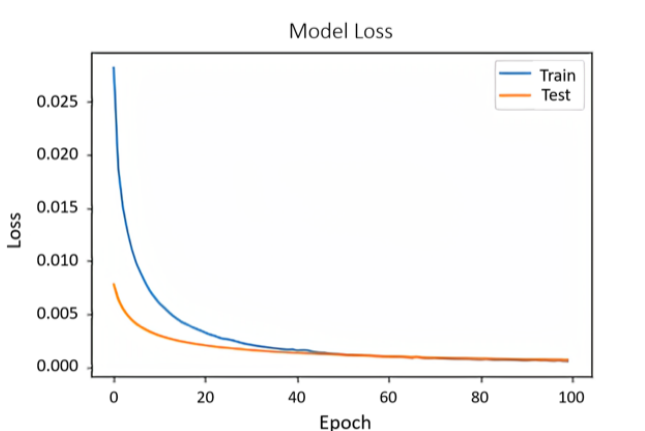
Figure 9. Overfit of the model.